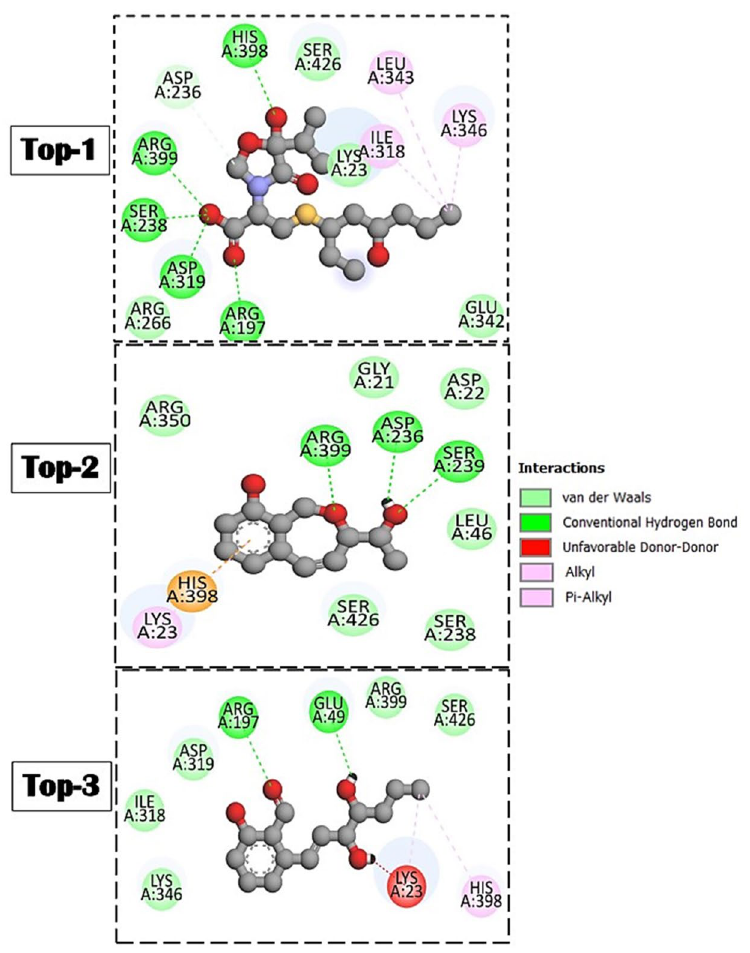
Figure 4. Chemical interactions produced by compounds at the docked pocket of EPSP enzyme. As can be seen, several van der Waals and hydrogen bond interactions were observed as key to stable binding of the compound to the